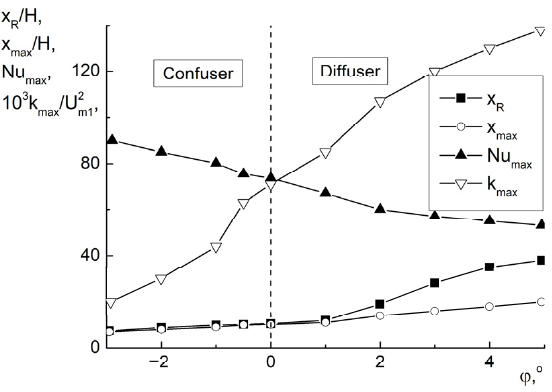
Figure 6. Effect of LPG on recirculating length x R , location of heat transfer maximum x max , value of maximal Nusselt number Nu max , and maximum of TKE k max in gas-droplet flow in pipe SE. M L 1 = 0.05, d 1 = 30 µ m.